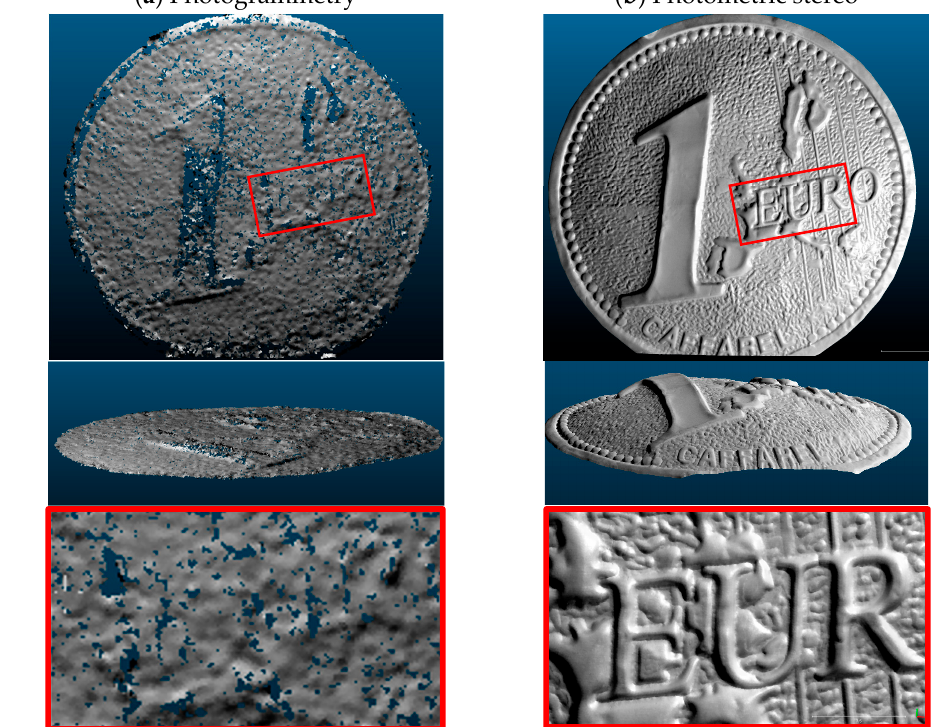
Figure 2. Visual comparison between photogrammetry and photometric stereo in terms of low and high-frequency information retrieved by the two techniques using the same dataset with the same configuration adopted from [25]. ( a ) accurate low-frequency information but noisy 3D details de- rived with photogrammetry; ( b ) high-details but deformed global shape derived with photometric stereo. Experiment details for this object (object F) with a comprehensive quantitative comparison are described in Section 5.